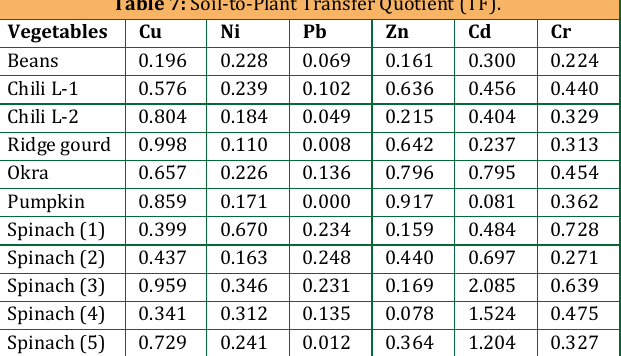
Table 7: Soil-to-Plant Transfer Quotient (TF).